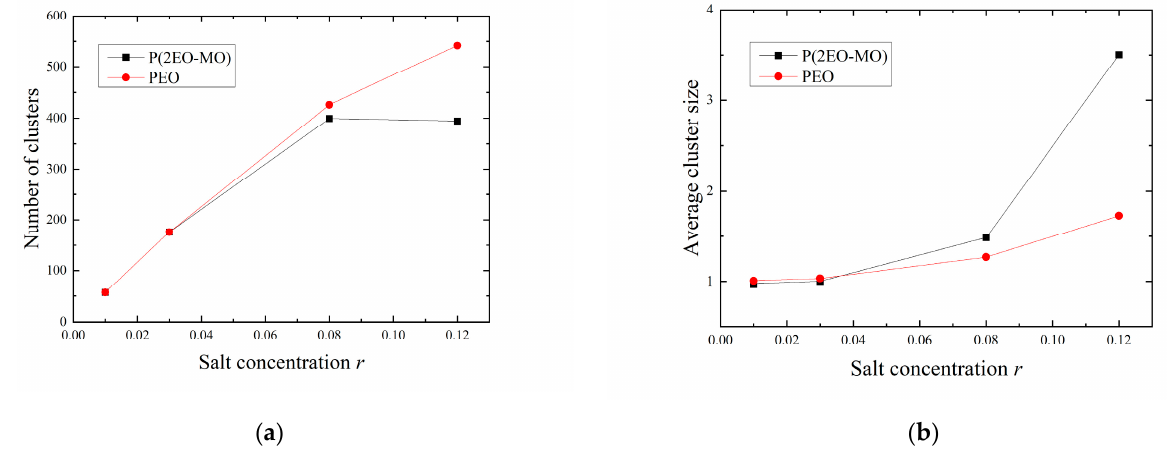
Figure 6. ( a ) Number of LiTFSI clusters and ( b ) average size of LiTFSI clusters.